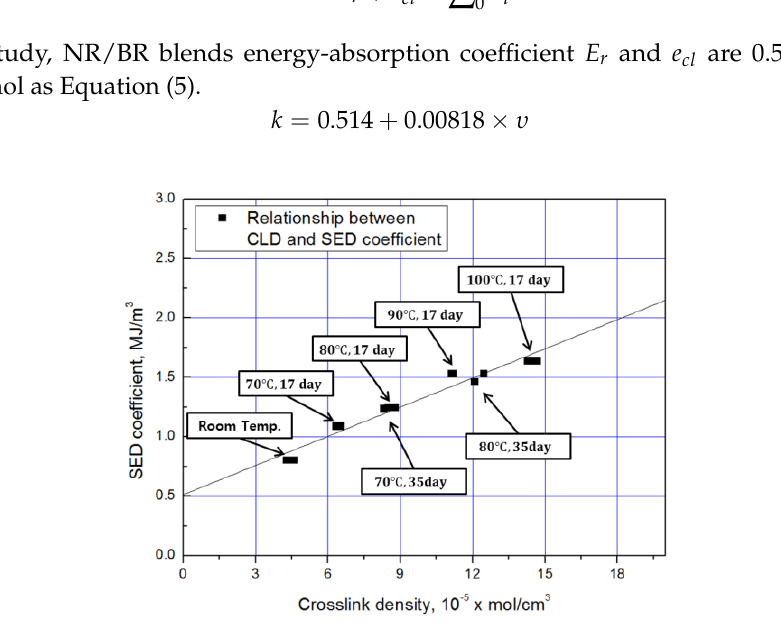
Figure 2. Relationship between CLD and SED function with constant ( k ).